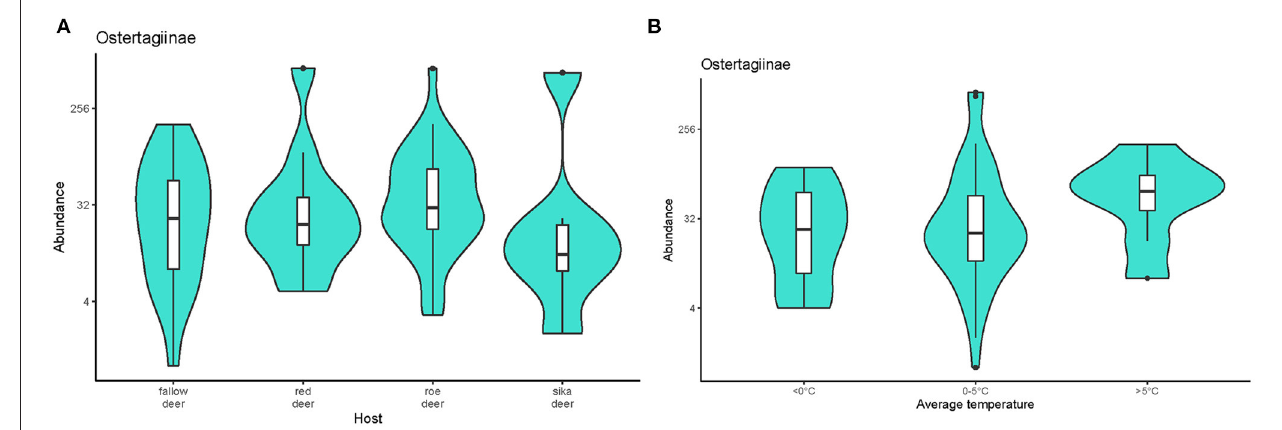
FIGURE 4 | Violin plots representing the abundance of nematodes from the subfamily Ostertagiinae recovered (A) from the cervid hosts and (B) during periods with different monthly average temperatures. Medians are displayed in the boxplots inside the violin plots. Black dots symbolize outliers. The data on pooled ostertagid abundance were